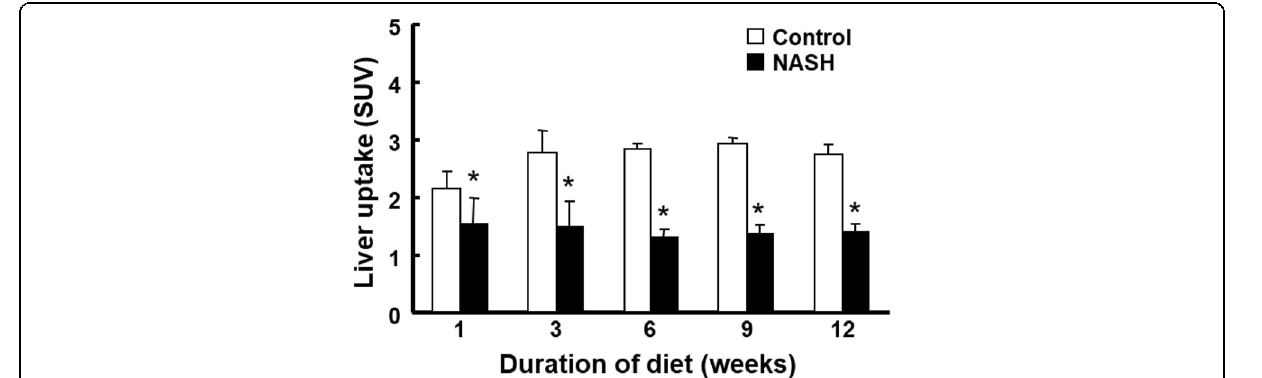
Fig. 3 Liver uptake of 18 F-BCPP-BF in mice fed choline-deficient, L -amino acid defined, high-fat diet and in age-matched control mice. Values represent the summation of standard uptake value (SUV) from 20 to 40 min after injection of 18 F-BCPP-BF. Data are presented as the mean ± standard deviation of 4 – 6 mice per group except for the 18-week-old nonalcoholic steatohepatitis (NASH) group, where N = 3. * P <